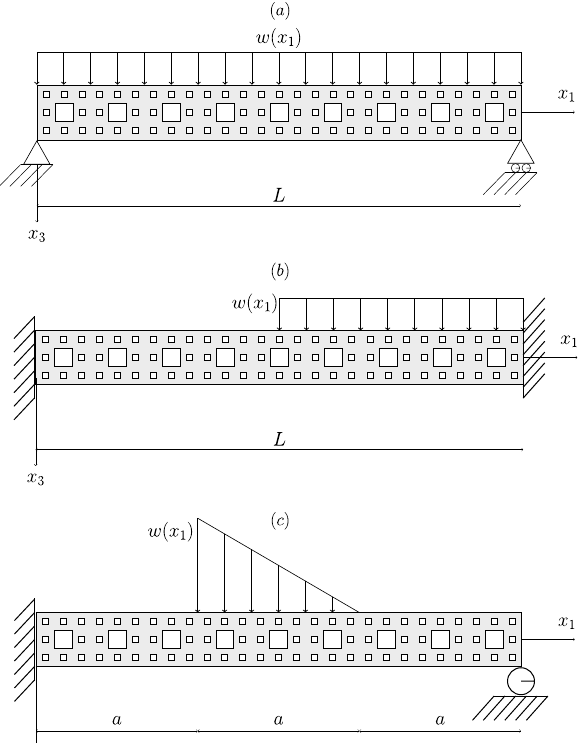
Figure 4. Classical beams with fractal geometry and cross-section type Sierpinski carpet, ( a ) simply supported, and ( b ) fixed, and ( c ) propped